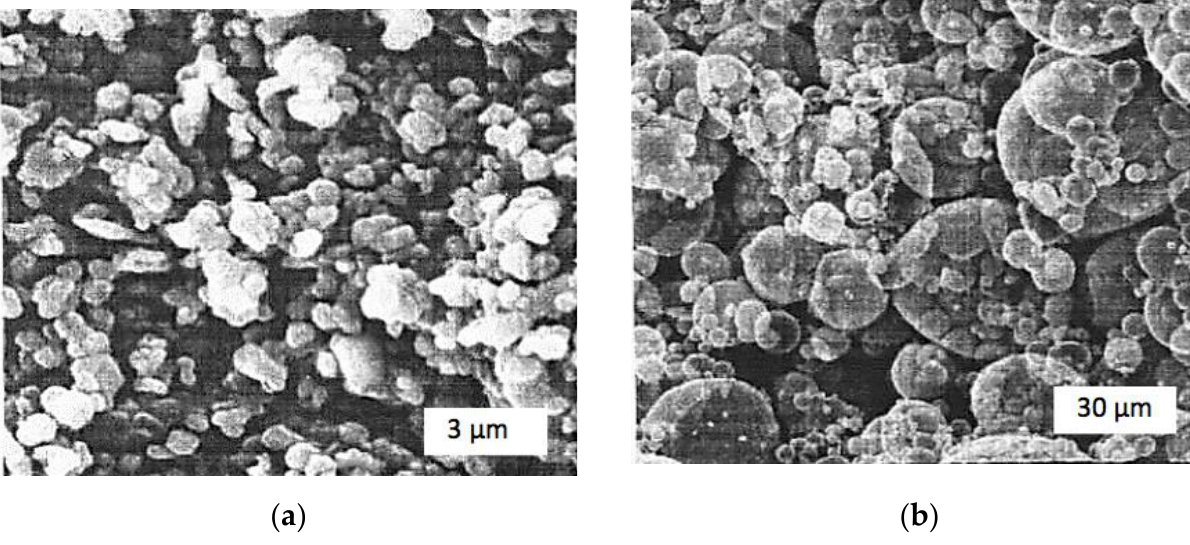
Figure 1. SEM images of the initial powders: ( a ) Cr 2 O 3 ; ( b ) Al.